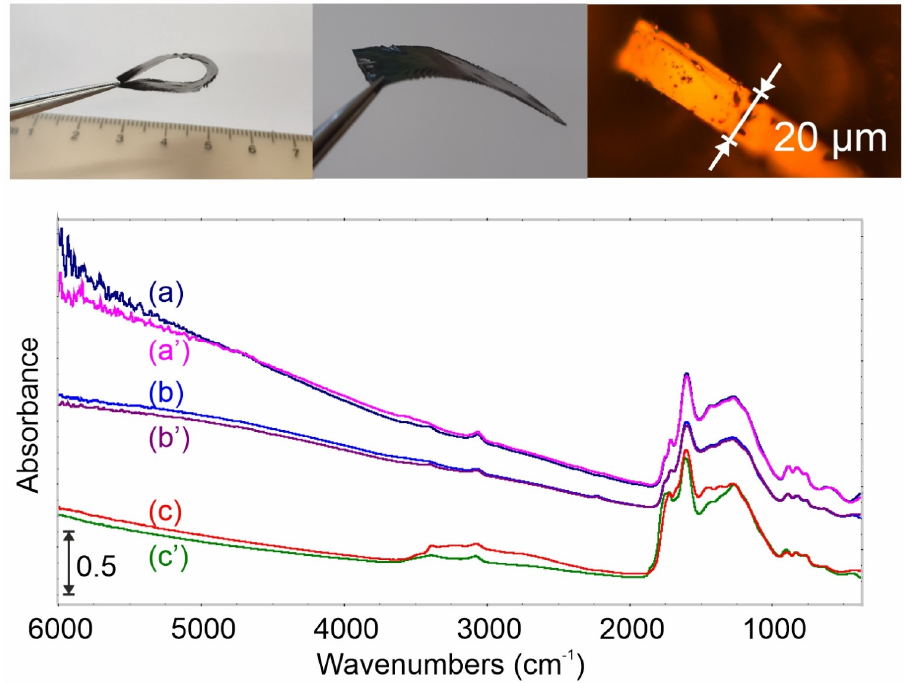
Figure 1. Upper panel—images of carbon film; bottom panel—FTIR spectra of tested materials (a) C des , (b) C des N, (c) C ox , respectively a, b, c, before, and a’, b’, c’ after NH 3 adsorption.